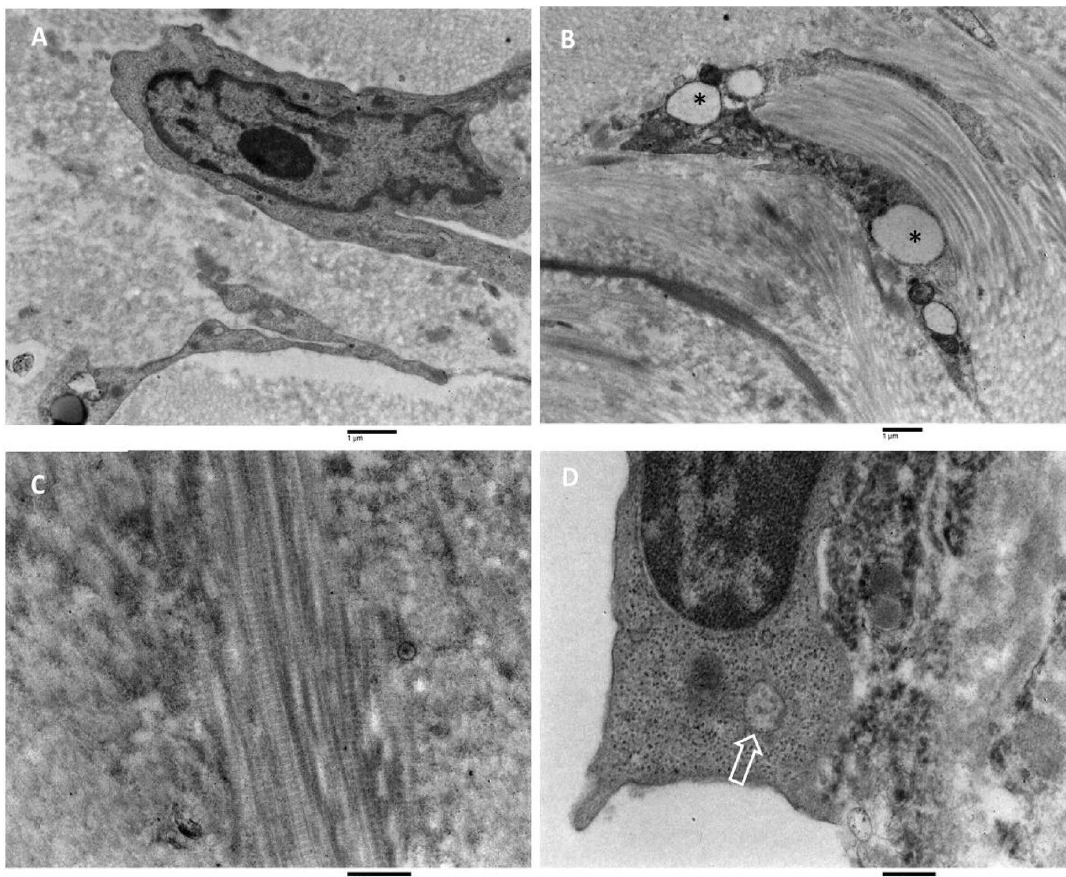
Figure 8. Transmission electron microscopy of the CSDH outer membrane. ( A , B ) flattened and elongated cells containing typical organelles in their cytoplasm were observed. Note, in ( B ), dilated vesicles of the rough endoplasmic reticulum (asterisks); A = 16,800 ×, bar = 1 µm; B = 13,400 ×, bar = 1 µm. ( C ) collagen fibers were strictly packed, running in perpendicular planes. Collagen fibers showed the typical cross-banded axial periodicity of 64 nm. 35,900 ×, bar = 600 nm. ( D ) endothelial cells showed the presence of multivesicular bodies (arrow). 44,900 ×, bar = 400